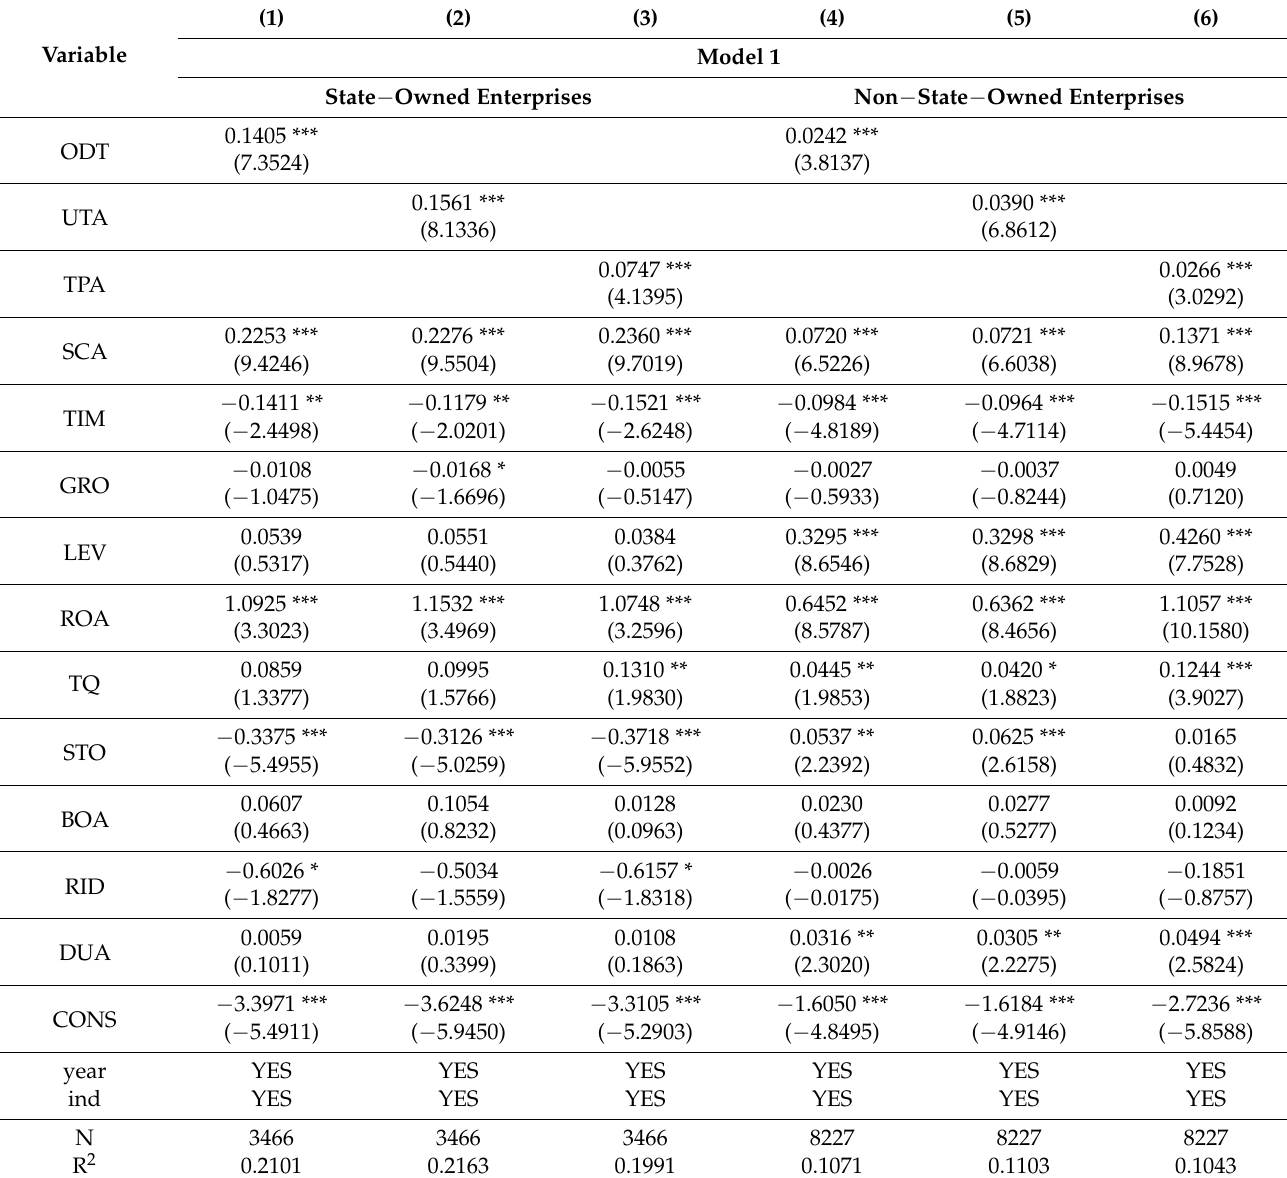
Table 8. Group test results according to the nature of property